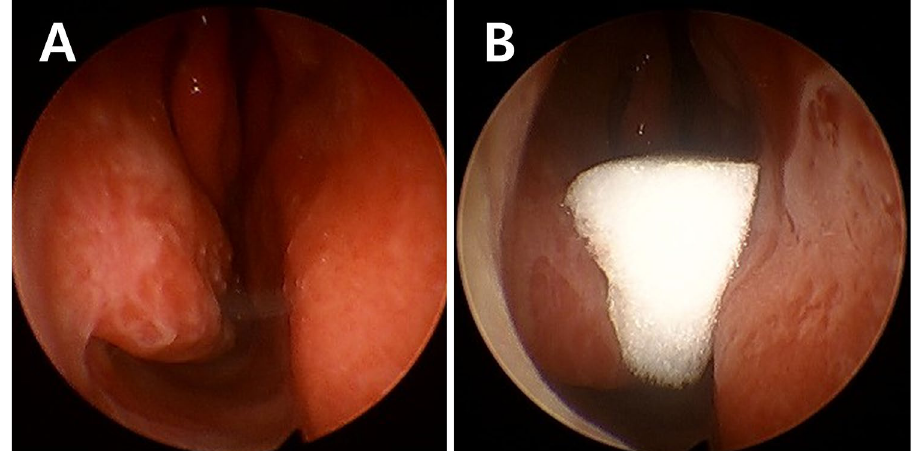
Figure 2. Nasal secretion collection. Upon visualization of the nasal cavity with the 30-degree endoscope, 20 mm × 10 mm × 5 mm cubic piece of synthetic polyurethane sponge (NasoPore) cubic piece was placed in the space between inferior turbinate, middle meatus, and nasal septum. The inserted cube was removed after 10 min in each nasal